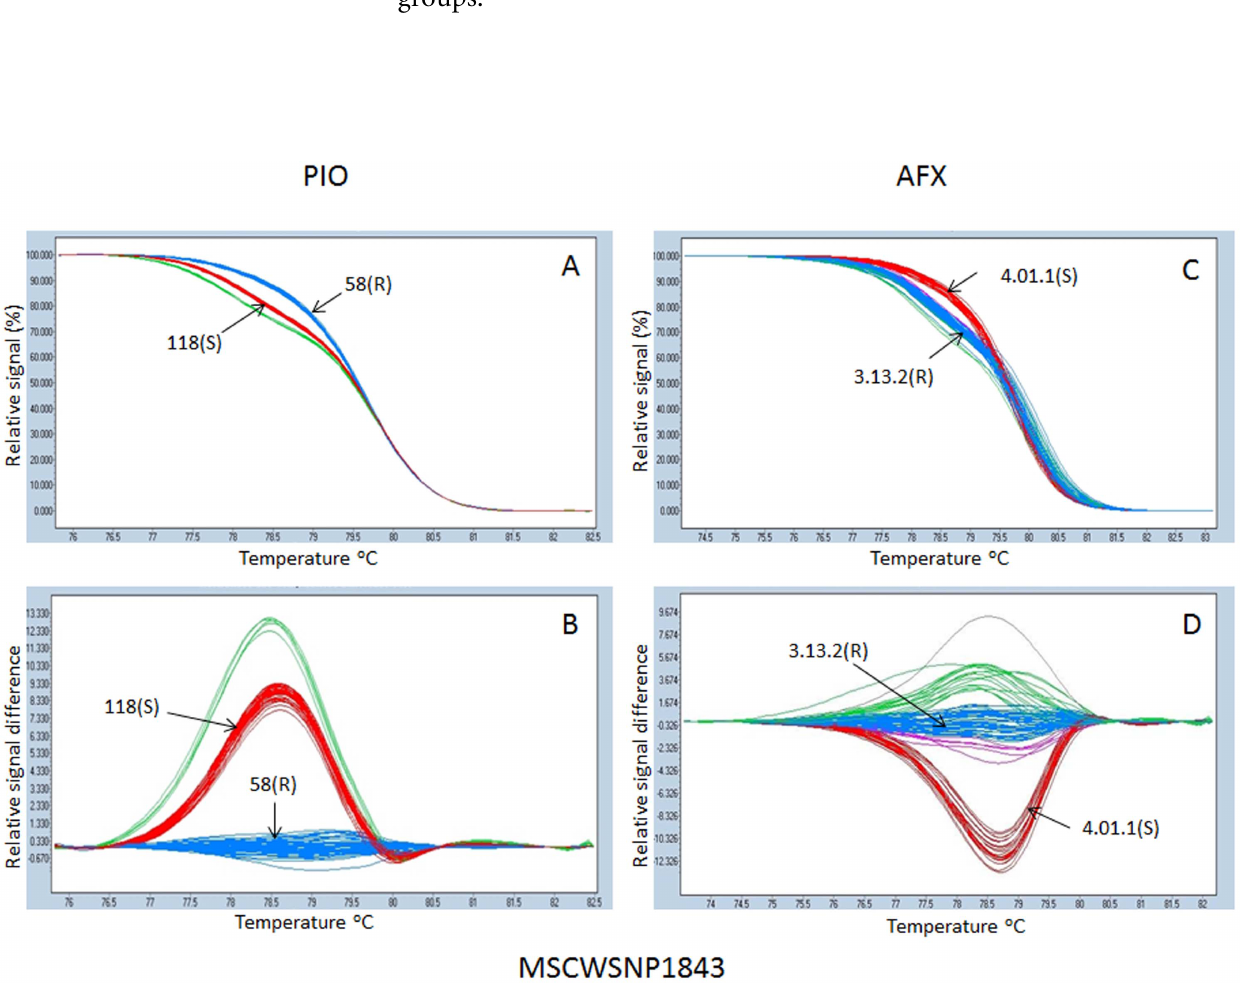
Fig. 2. High resolution melting profiles of SNP markers MSCWSNP1843 in the Pioneer (PIO) (A, B) and Alforex (AFX) (C, D) populations. The real time PCR was performed by LightCycler 480) and the HRM profiles were analyzed using the gene scanning module software. Normalized melting curves (A, C) and temperature shift difference plots (B, D) are presented. Three groups of genotypes were distinguished by three colors (red, blue and green). Melting curves for parents in each population are indicated by arrows. Resistant parents: 58(R) 5 55V50-58(R) (Pioneer) and 3.13.2 (R) 5 CW065006-3-13-2 (R) (Alforex), susceptible parents: 118(S) 5 55V50-118(S) (Pioneer) and 4.01.1(S) 5 CW065006-4-01-1(S)